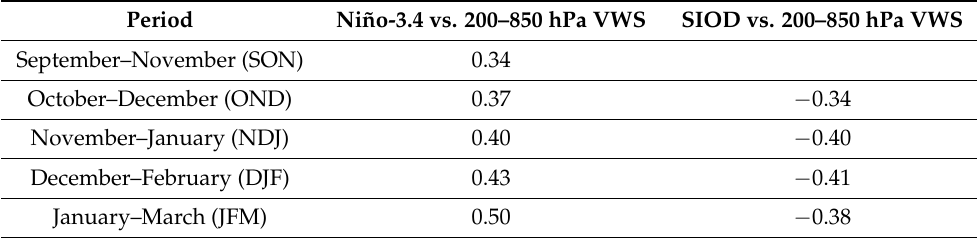
Table 1. Correlation coefficients of 200–850 hPa VWS vs. Niño-3.4 and